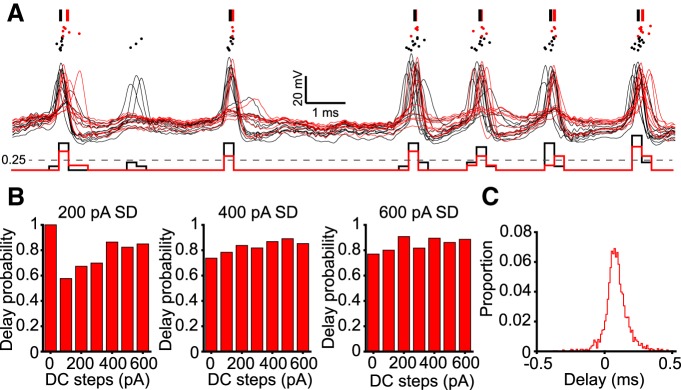
ChABC-treated cells consistently fired later than P-ase-treated cells. A, Each overlaid trace is from a different P-ase-treated (black) or ChABC-treated (red) cell. A dot raster is plotted above the spike trains, with each row indicating a different cell. The PSTH below indicates how spike events were identified. When a 0.25 ms bin reached a threshold where ≥25% of P-ase-treated cells fired, a mean spike time was calculated for spikes occurring within 1 ms centered on the bin. The vertical lines above indicate the mean spike time of the spikes within each 1 ms spike event. B, The probability of the ChABC-treated cells to fire later than the P-ase-treated cells during these spike events was high (> 50%) across all levels of gain and DC steps. C, The distribution of the delays of spike events is shifted to the right, indicating that spikes usually occurred later in ChABC-treated cells than P-ase-treated cells.